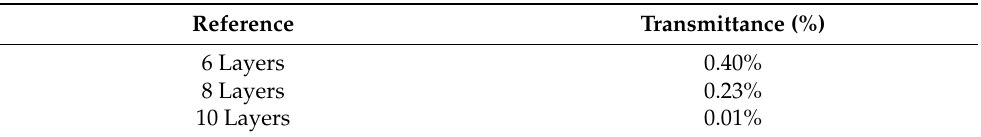
Table 6. Real transmittance of the studied samples.